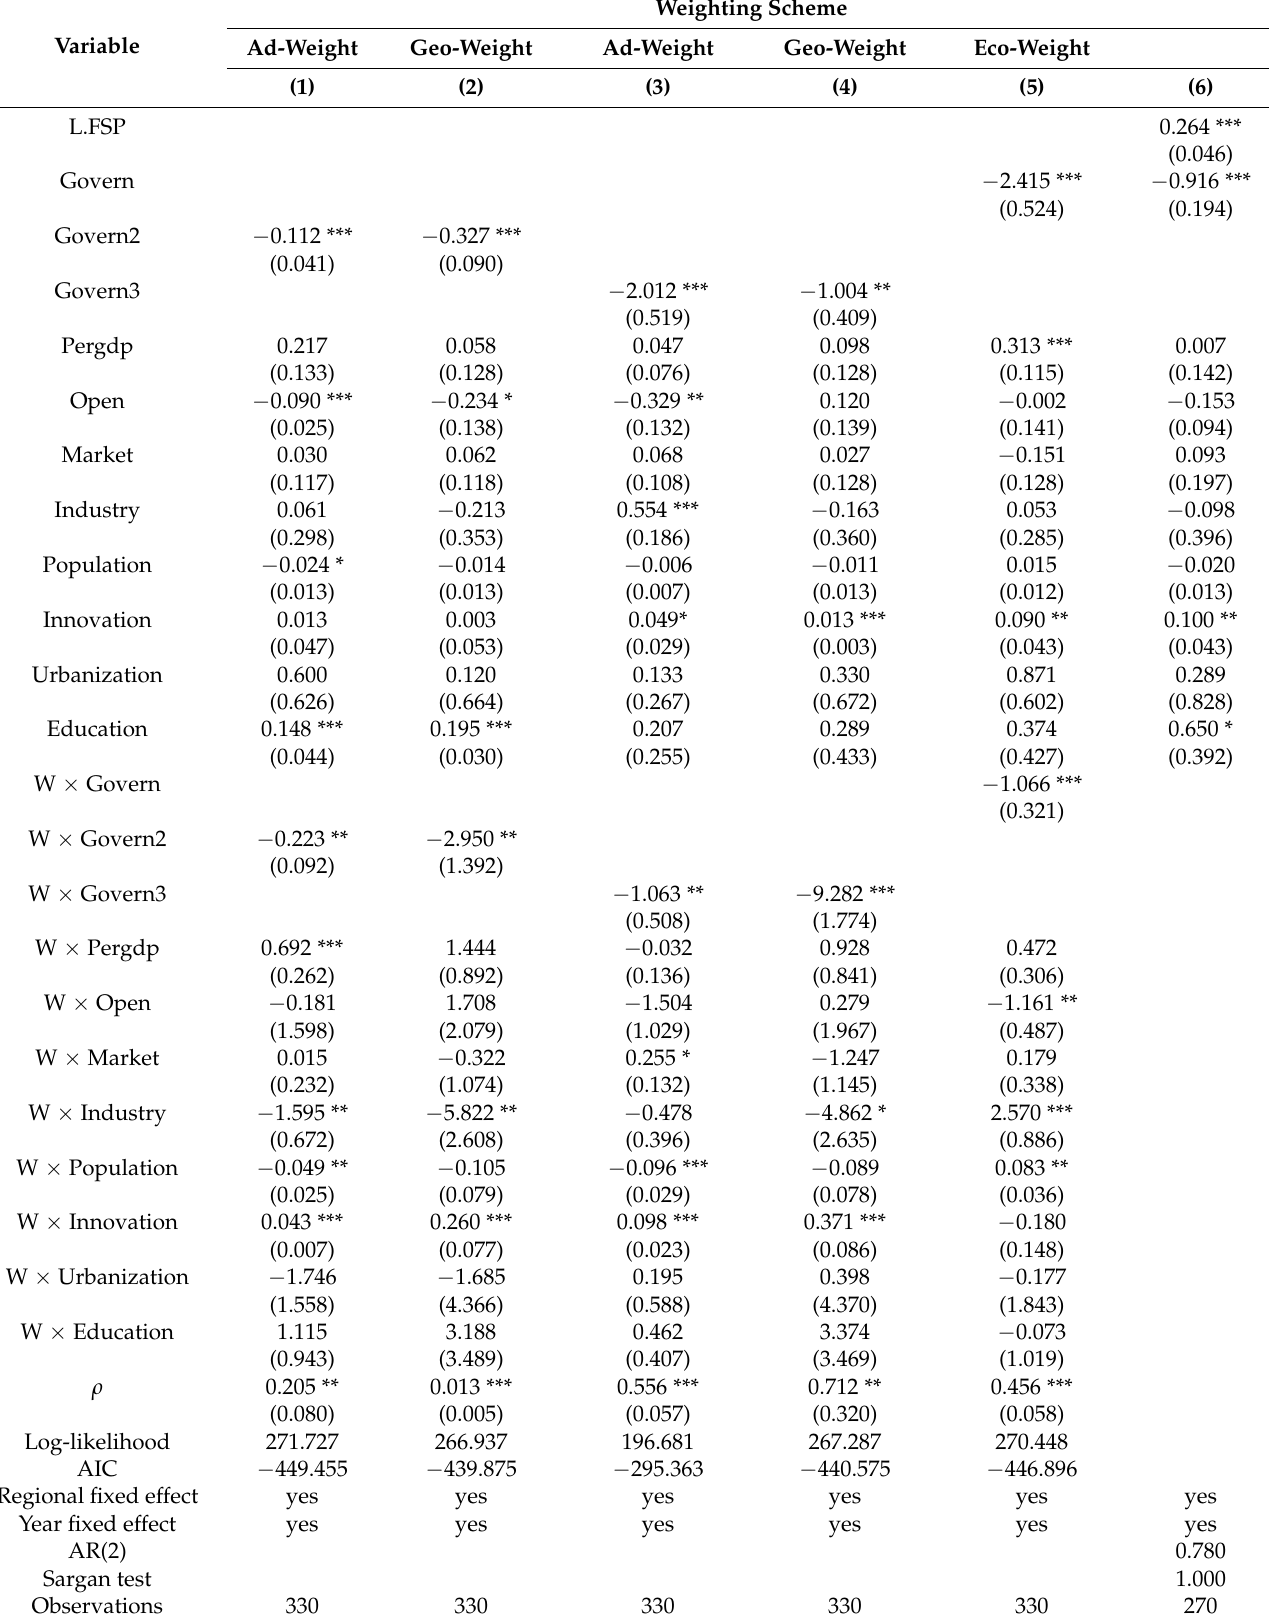
Table 7. Results of robustness